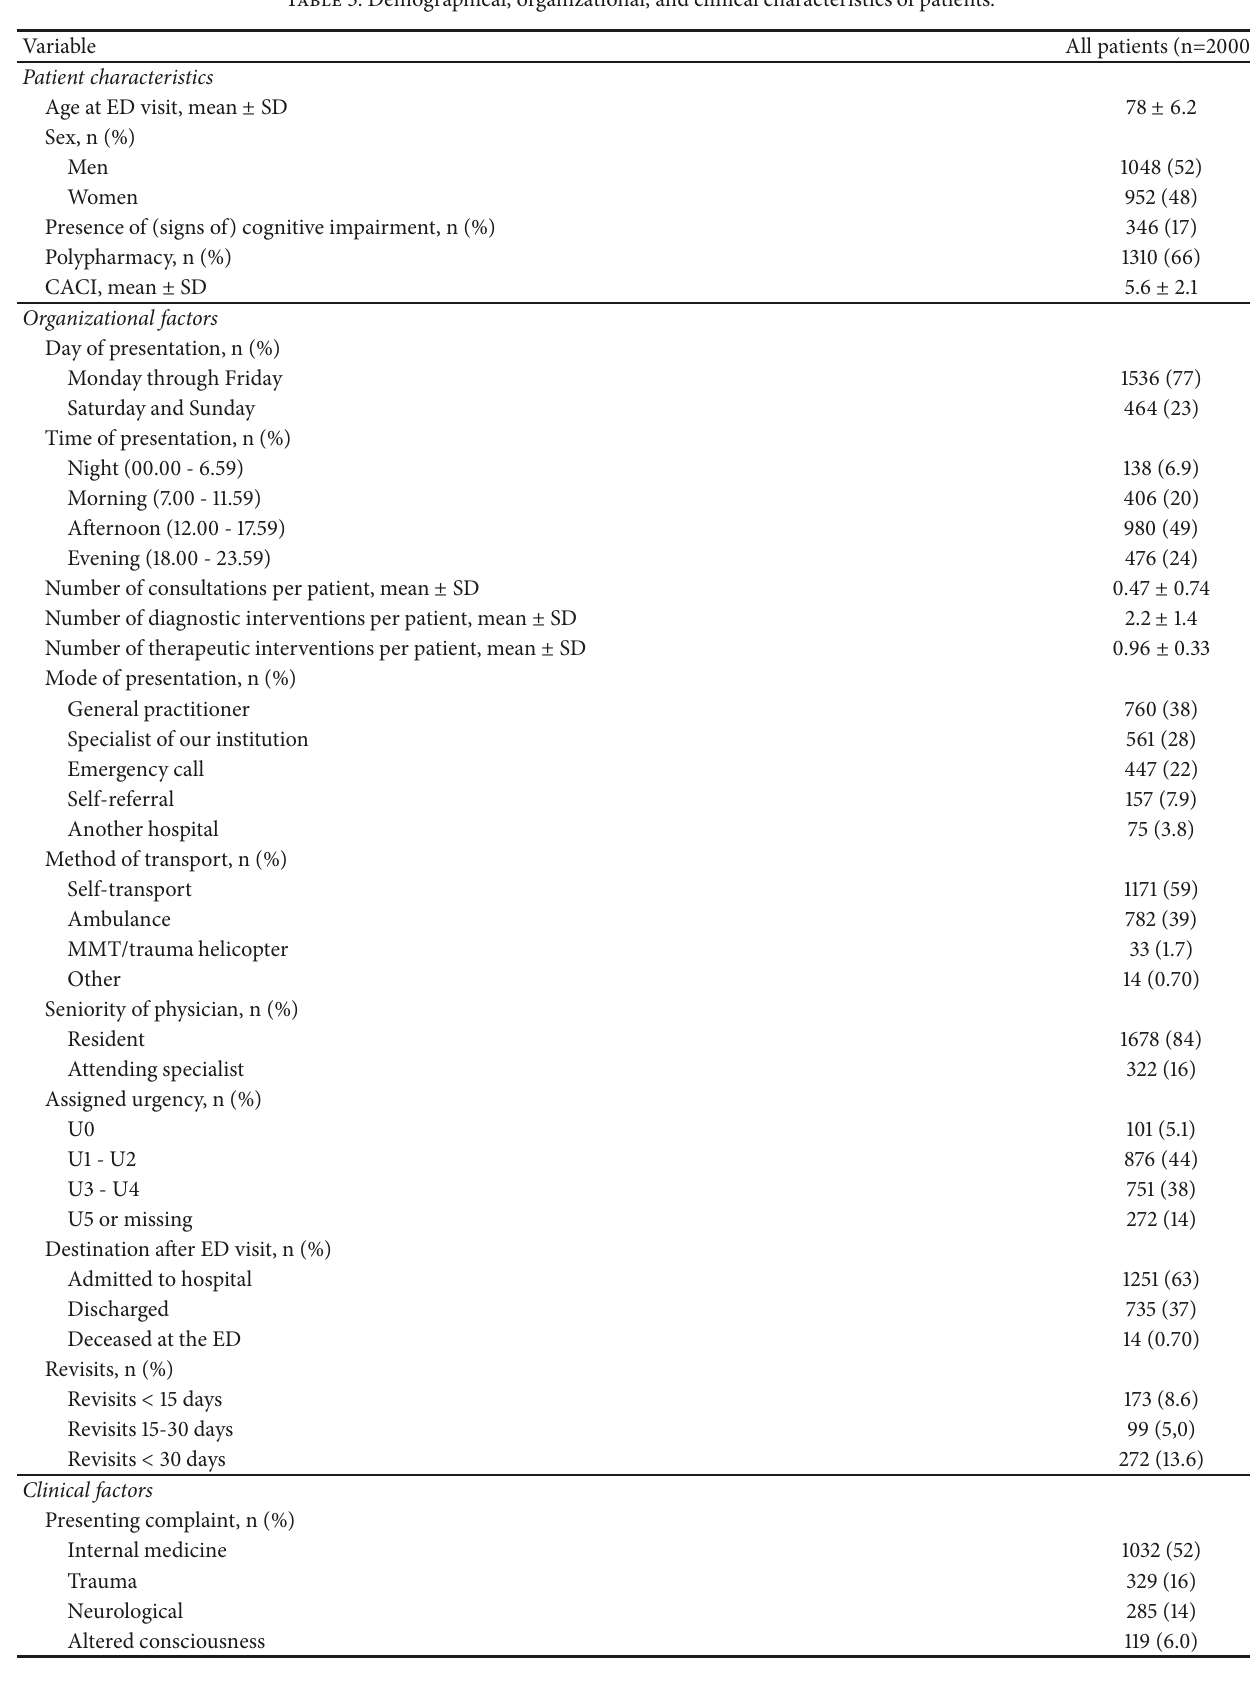
Table 3: Demographical, organizational, and clinical characteristics of